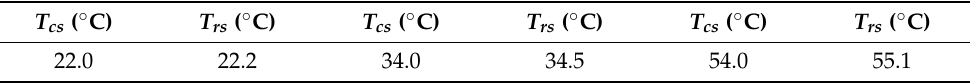
Table 4. Comparison of capacitor case temperatures T cs with temperatures of the cylinder (made of aluminum and polypropylene) T rs for T cs = 22.0 ◦